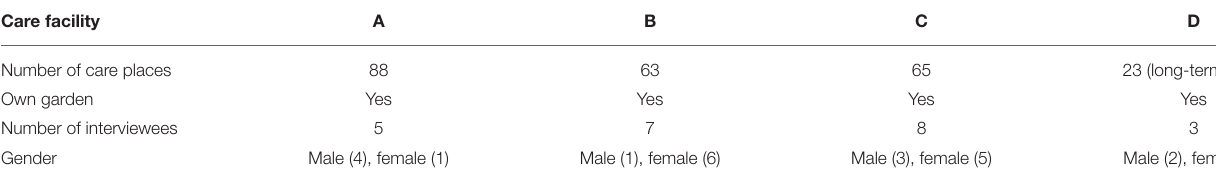
TABLE 1 | Care facilities and survey